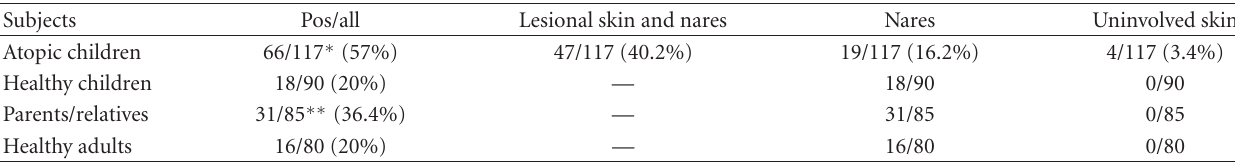
Table 1: Prevalence of S. aureus colonization in patients, family members, and controls. Contingency analysis and Fisher’s exact test: ∗ P < 0 . 0001; ∗∗ P = 0 . 0036.